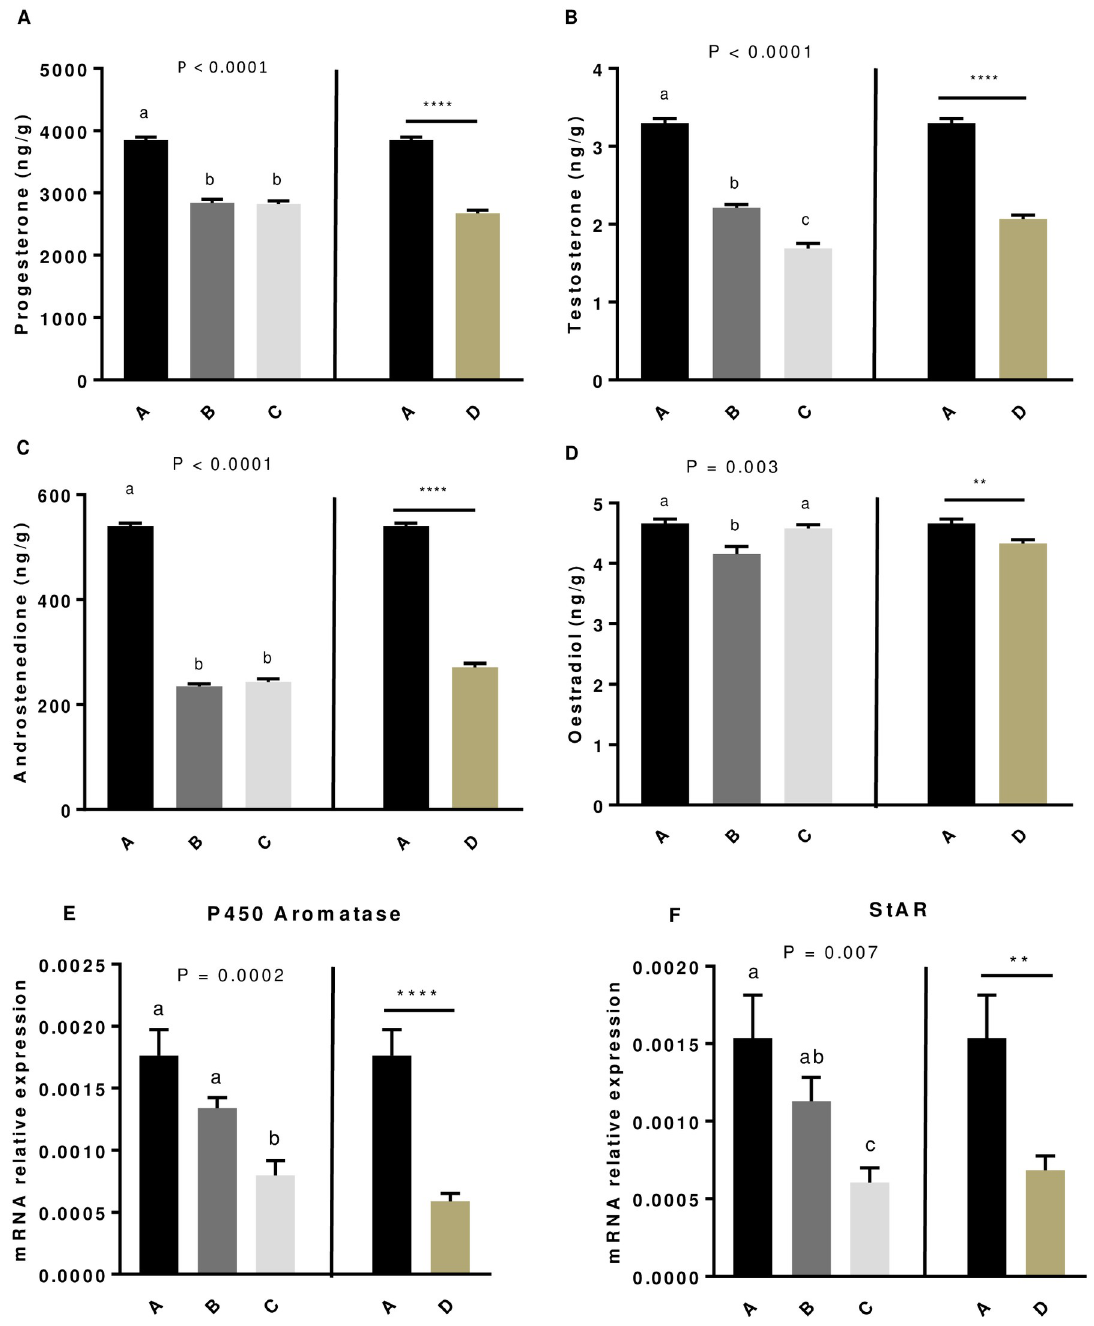
Fig 3. Levels of progesterone (A), testosterone (B), androstenedione (C) and oestradiol (D) in egg yolk and P450 aromatase (E) and StAR (F) mRNA expression in granulosa cell from broiler hens fed with different concentrations of GSE. Steroids were extracted from 30 egg yolks for each group, at 33 weeks-old. mRNA was extracted from granulosa cells of 10 preovulatory follicles for each group. A: animals fed with control diet without GSE supplementation, B and C: animals supplemented with GSE at 0.5% and 1% of the total diet composition, respectively, starting at 4 week-old until 40 week-old (experiment 1) and D: supplementation with GSE at 1% of the total diet composition starting at hatching until 40 week-old (experiment 2). Results are presented as lsmeans ± S.E.M. P values and different individual letters indicate a significant effect of the diet between A, B and C groups (experiment 1) or between A and D groups (experiment 2). P value was considered as significant if P < 0.05. �� P < 0.005 and ���� P < 0.0001.